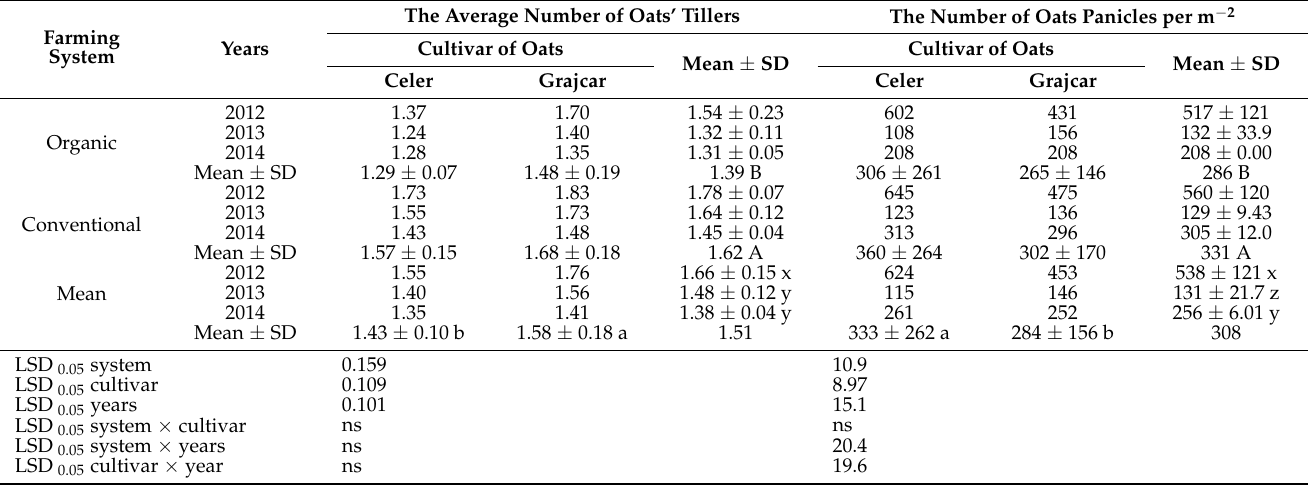
Table 6. The average number of tillers per oat plant and number of oats panicles per m − 2 in the oat-vetch mixtures, depending on the farming system and oat cultivar in 2012–2014.